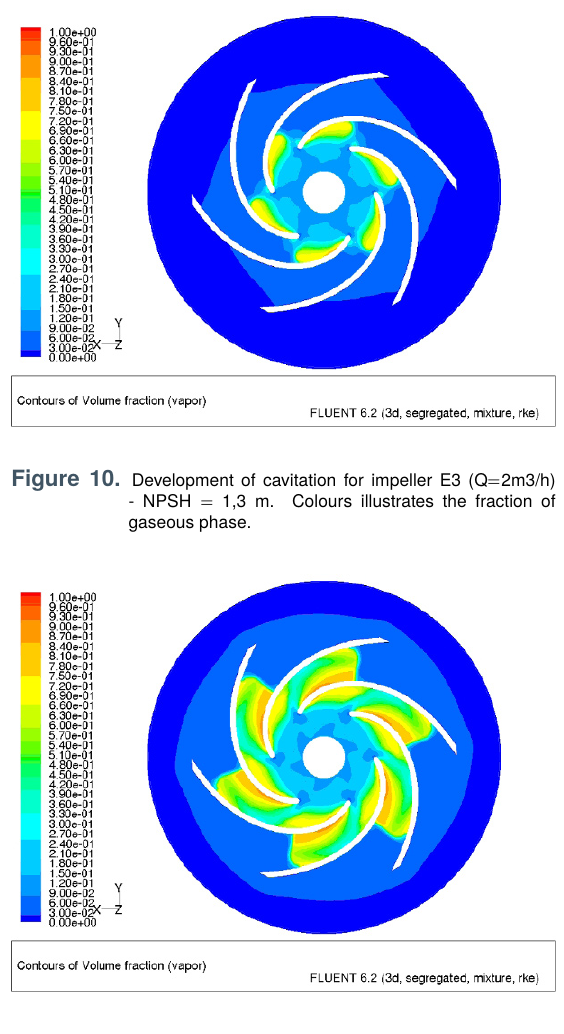
Figure 11. Development of cavitation for impeller E3 (Q - NPSH = 0,9 m. Colours illustrates the fraction of gaseous phase.